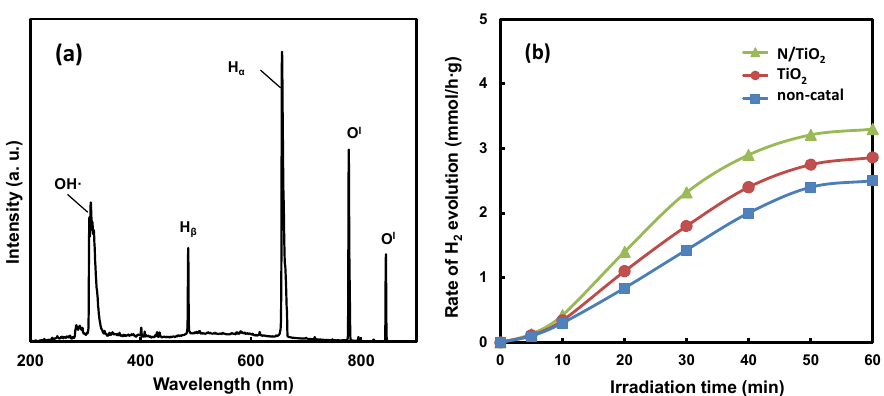
Figure 9. ( a ) OES of pure water and ( b ) rate of hydrogen evolution by LPP irradiation.